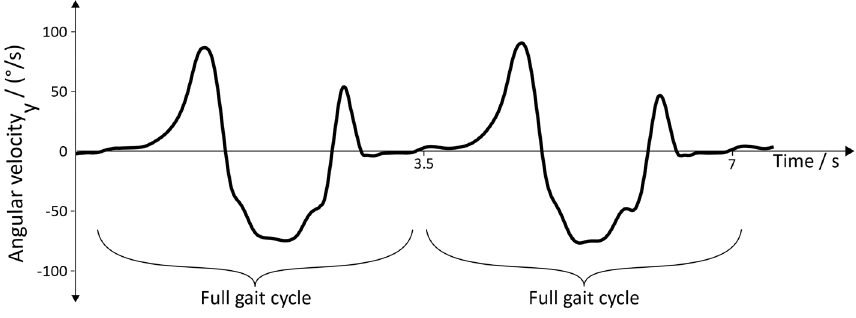
Figure 11. Shape of the angular velocity during two gait cycles .